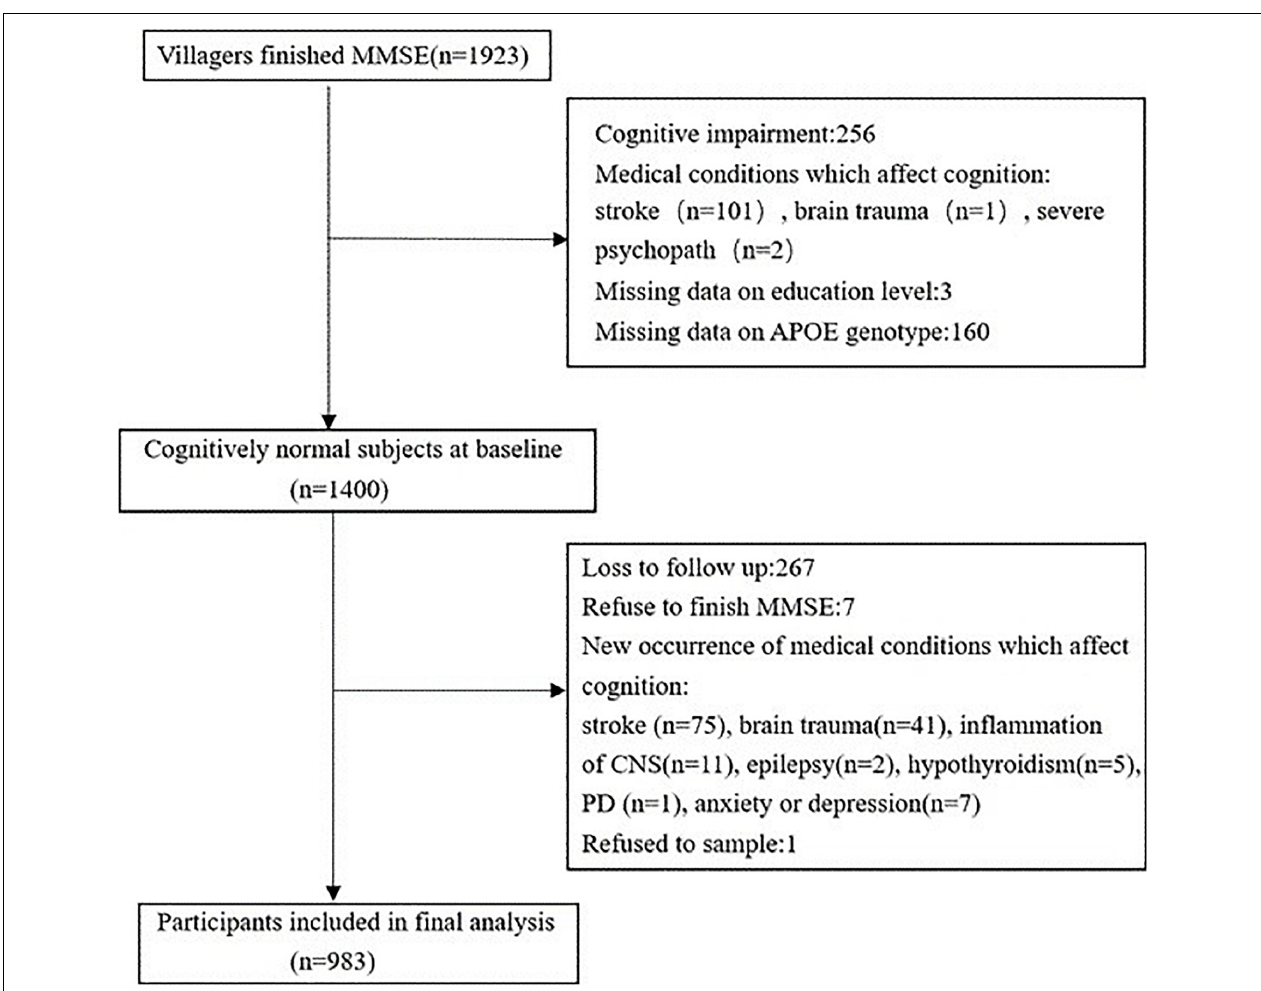
FIGURE 1 | Flow chart of participant